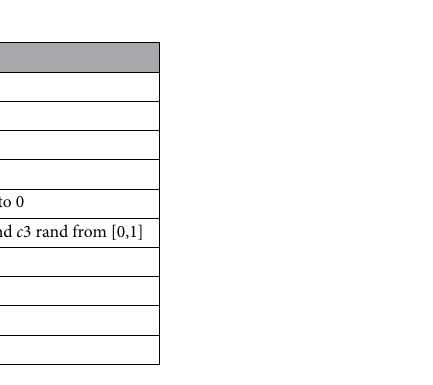
Table 8. Configuration of control parameters of the metaheuristics that were implemented and included in the comparative analysis.